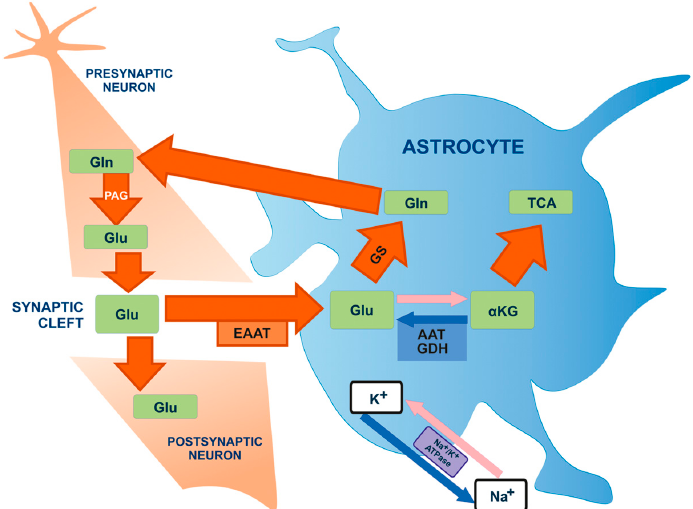
Figure 5. Glutamate-glutamine cycle [77]. Glutamate (Glu) molecules are released